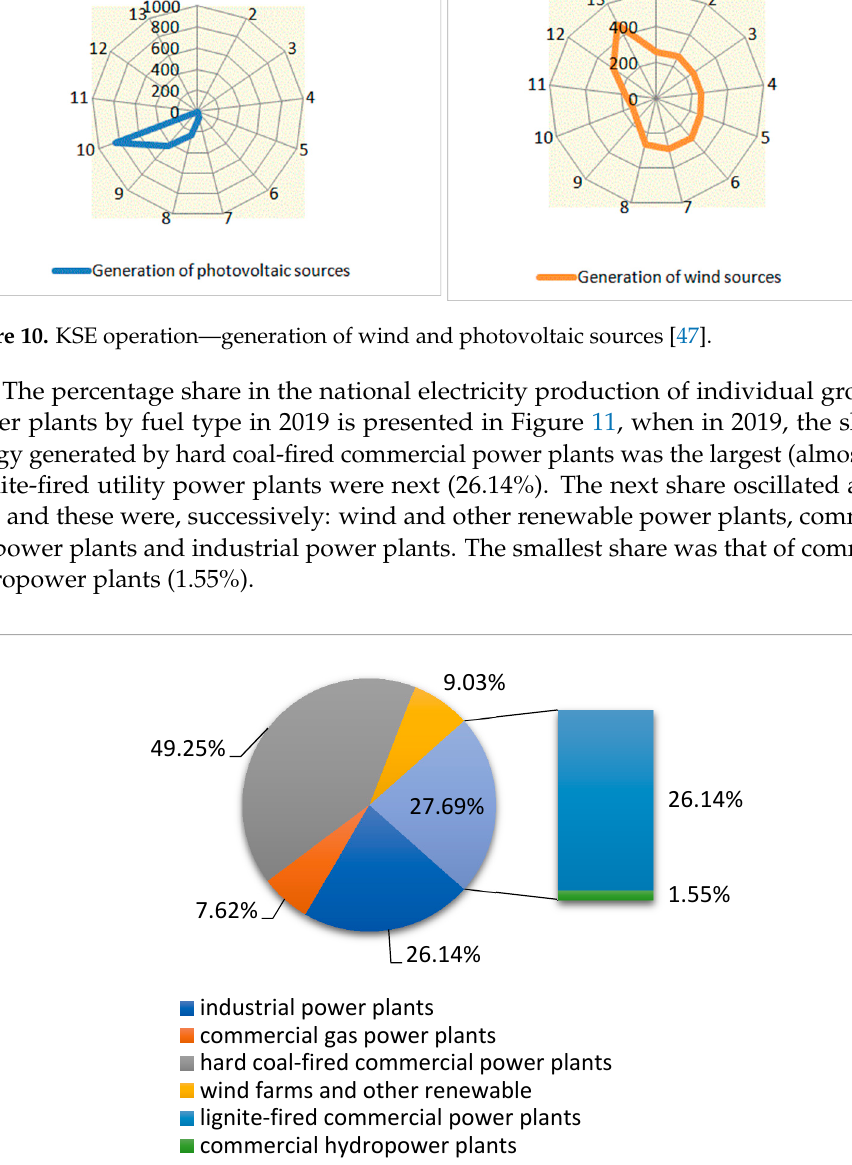
Figure 12. Electricity generation in Germany (TWh) [49]. Electricity production in Germany [50,51] shows the 12-month average data in the figure above (Twh generation). Energy production in Germany shows the 12-month av- erage data in the figure above. Electricity production in Germany is very extensive and consists of nuclear, gas and renewable energy, as well as hard coal and lignite. The pro- duction of electricity from coal has a downward trend; this is the result of charges for CO 2 emissions to the atmosphere and the decline in renewable energy prices, especially wind and sun. In the period from March 2019 to February 2020, Germany produced 140 (TWh) of electricity; compared to Poland, it is slightly less than the entire annual net electricity consumption. Figure 13 below presents Energy sources in German electricity production—12-month average